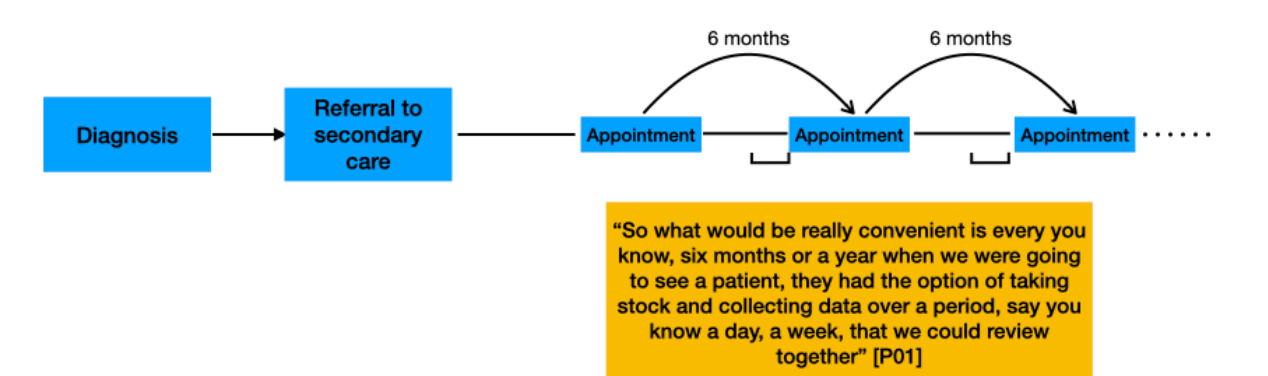
Figure 3. Participants’comments about the timing of the use of remote measurement technology in the multiple sclerosis care pathway, indicating the benefits of monitoring for a short period before an